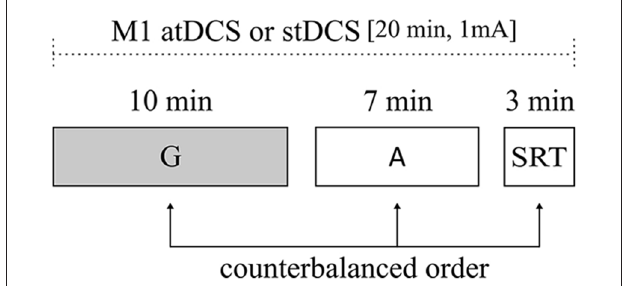
FIGURE 1 | Illustration of experimental design. All subjects underwent atDCS and stDCS separated by at least 1 week, in a counterbalanced order. The duration of the main task (gestural task) and of control tasks [attentional load and simple reaction time (RT) tasks] are shown. Order of task presentation was counterbalanced between subjects. G, gestural task; A, attentional load task; SRT, simple RT task; atDCS, anodal transcranial direct current stimulation (tDCS); stDCS, sham tDCS.